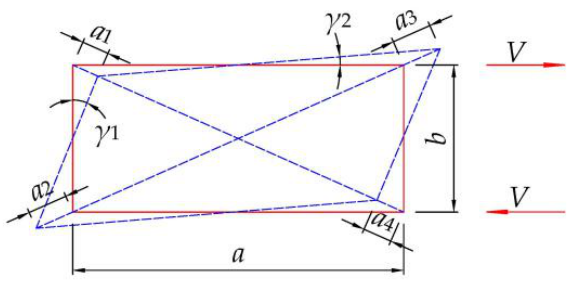
Figure 20. Calculation diagram of shear deformation.